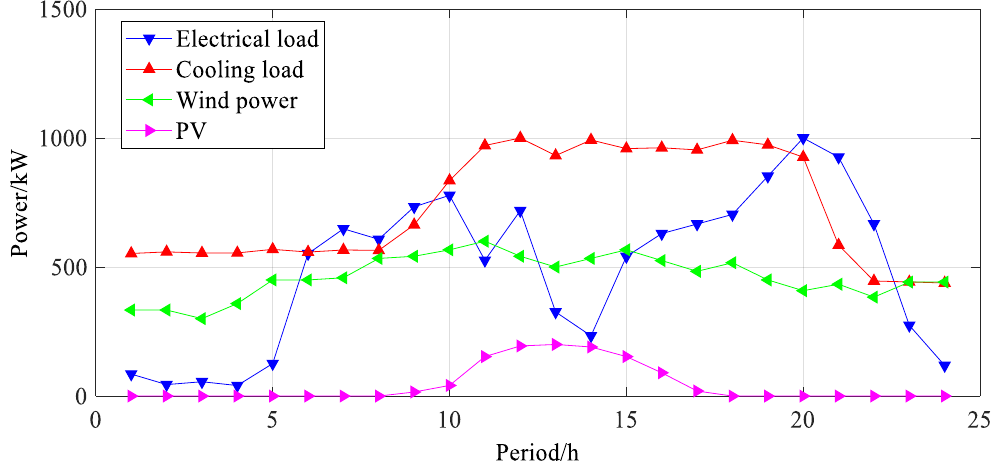
Figure 5. Wind power output, photovoltaic power output, power load, and cooling load curves within a typical day in winter (Photovoltaic: PV).